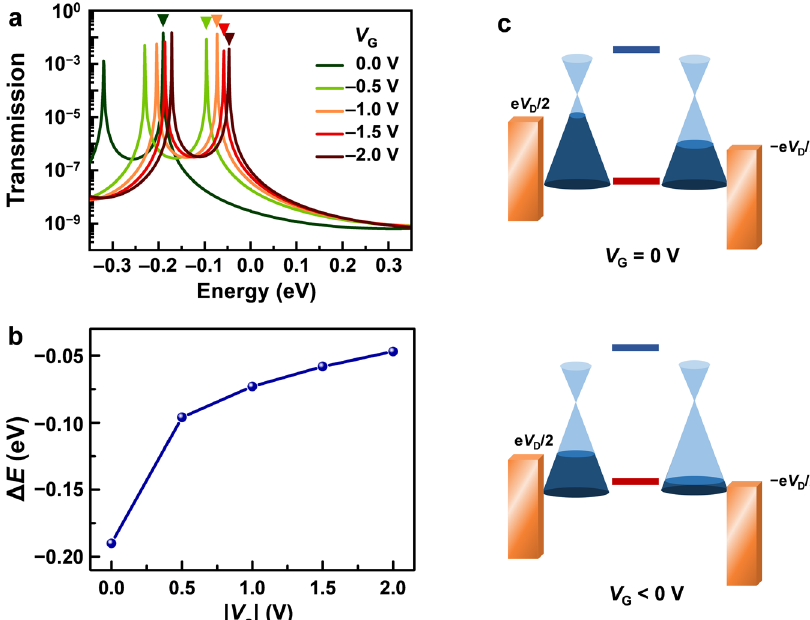
Fig. 4 Working mechanism of the Ru- o DAE single-molecule FETs. a Gate-dependent zero-bias transmission spectra at − 2.0 V ≤ V G ≤ 0 V with steps of 0.5 V. The downward triangles mark the p -HOMO for each case. b Energy gaps between the p -HOMO and the graphene Fermi level at various gate voltages. c Schematic energetic diagram showing the alignments between the molecular orbitals (red and blue lines) and the density of graphene electrodes in Ru- o DAE single-molecule transistors under application of different gate